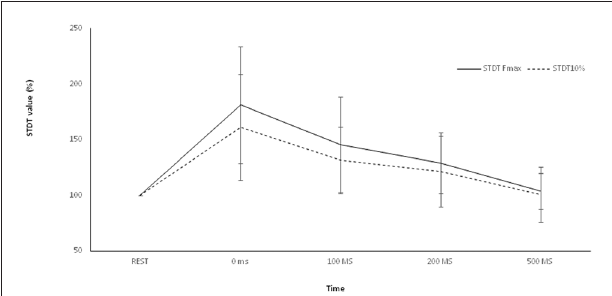
FIGURE 2 | Main experiment. ADM and FDI MEP amplitude and STDT value changes index finger flexion. The extent of ADM/FDI MEP amplitude and STDT values change was maximal at the onset of the movement and gradually returned to the baseline values. X axis refers to the time course (baseline, 0 ms, 100 ms, 200 ms, 500 ms). Y axis refers to the percentage of ADM/FDI MEP amplitude and STDT values changes during movement. Vertical bars denote SD.